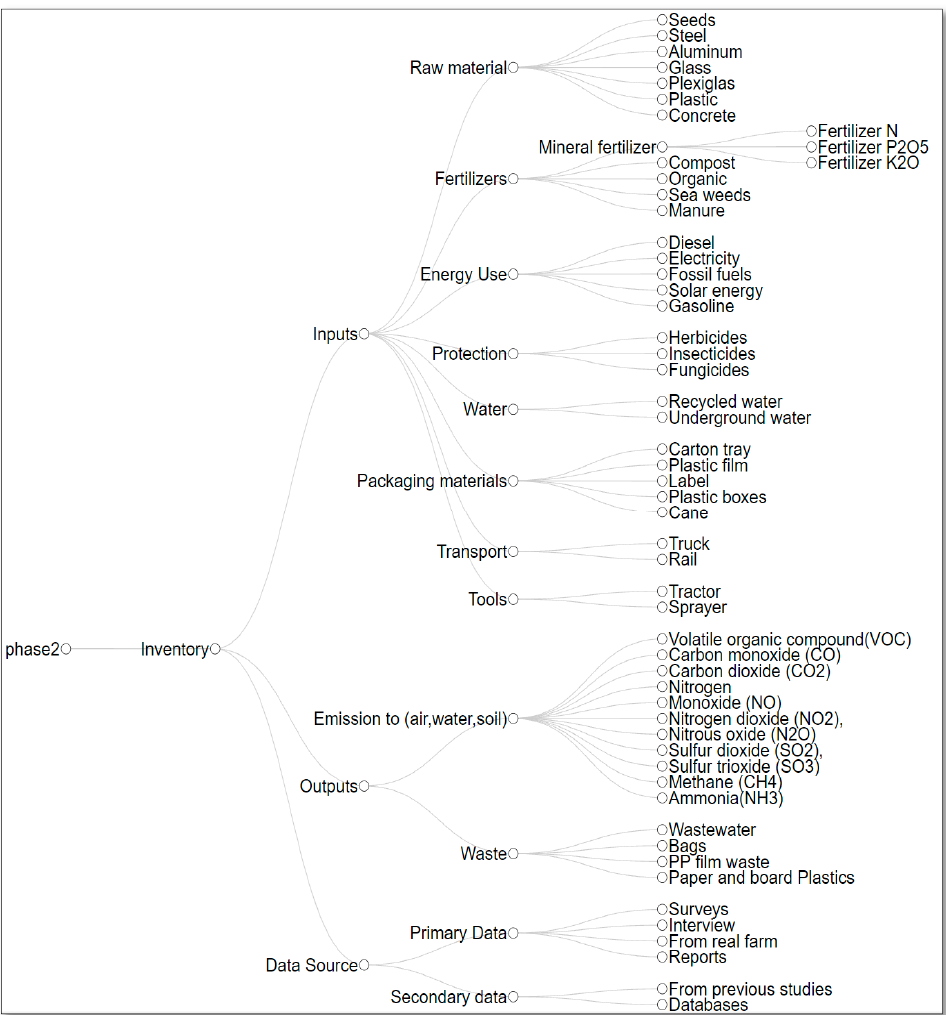
Figure 11. Phase 2 (inventory) of life cycle assessment (LCA).